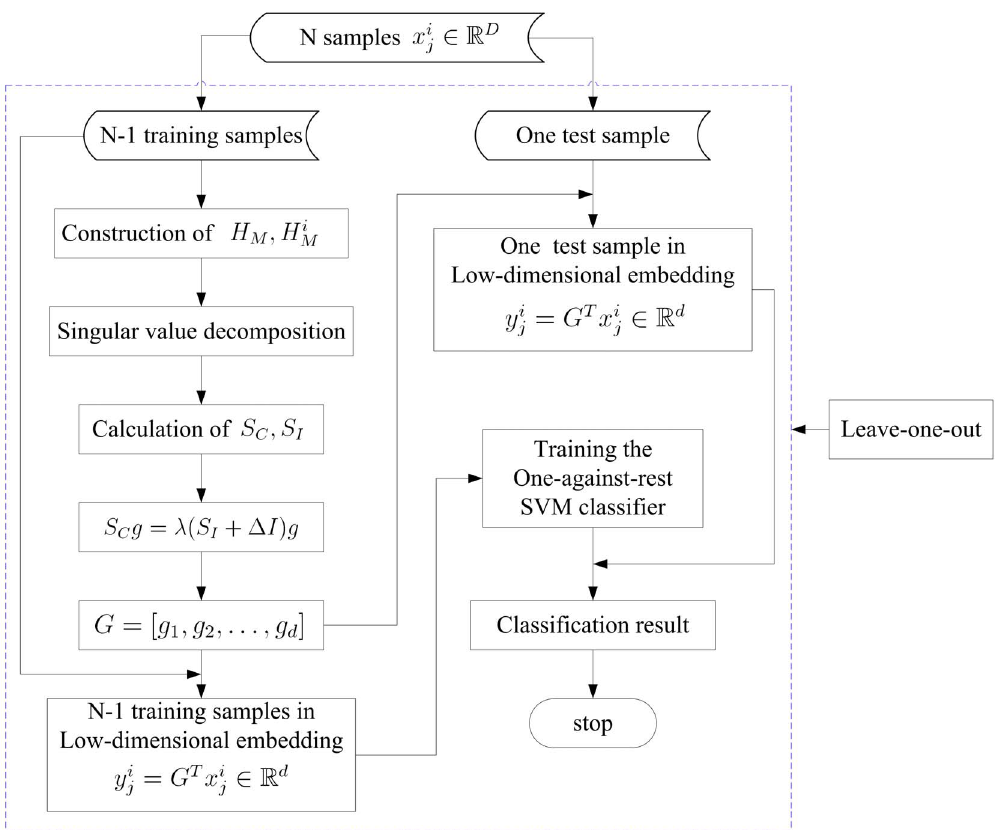
Figure 1. Flow chart of the intrinsicconnectome method.